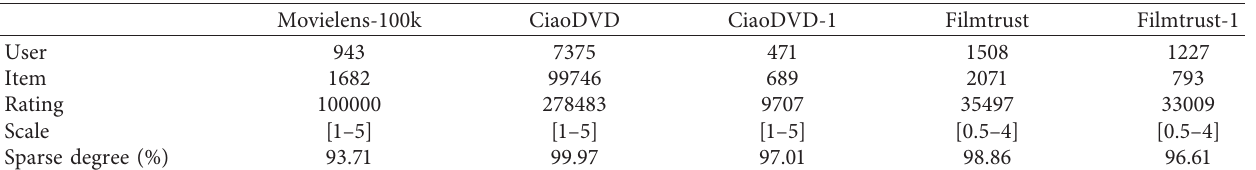
Table 2: Statistics of datasets.